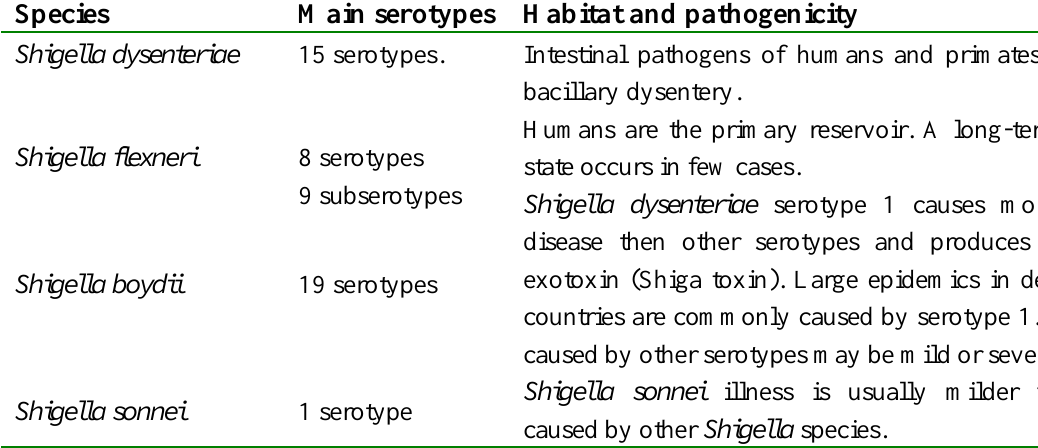
Table 5. Current taxonomy and nomenclature of the genus Shigella . Habitat and pathogenicity of species a